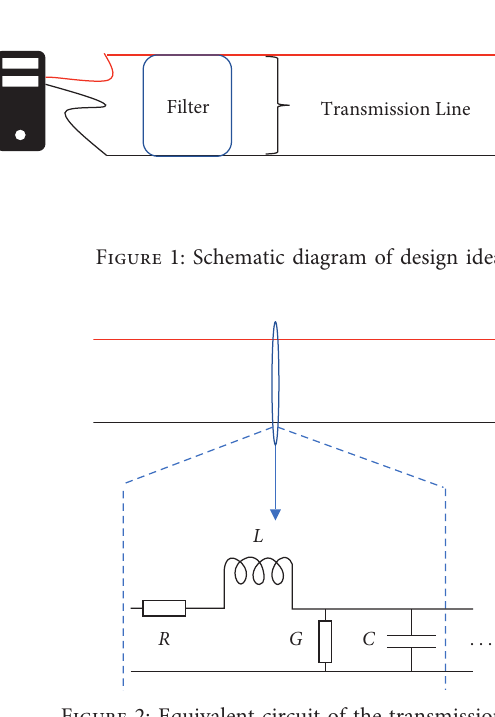
Figure 2: Equivalent circuit of the transmission